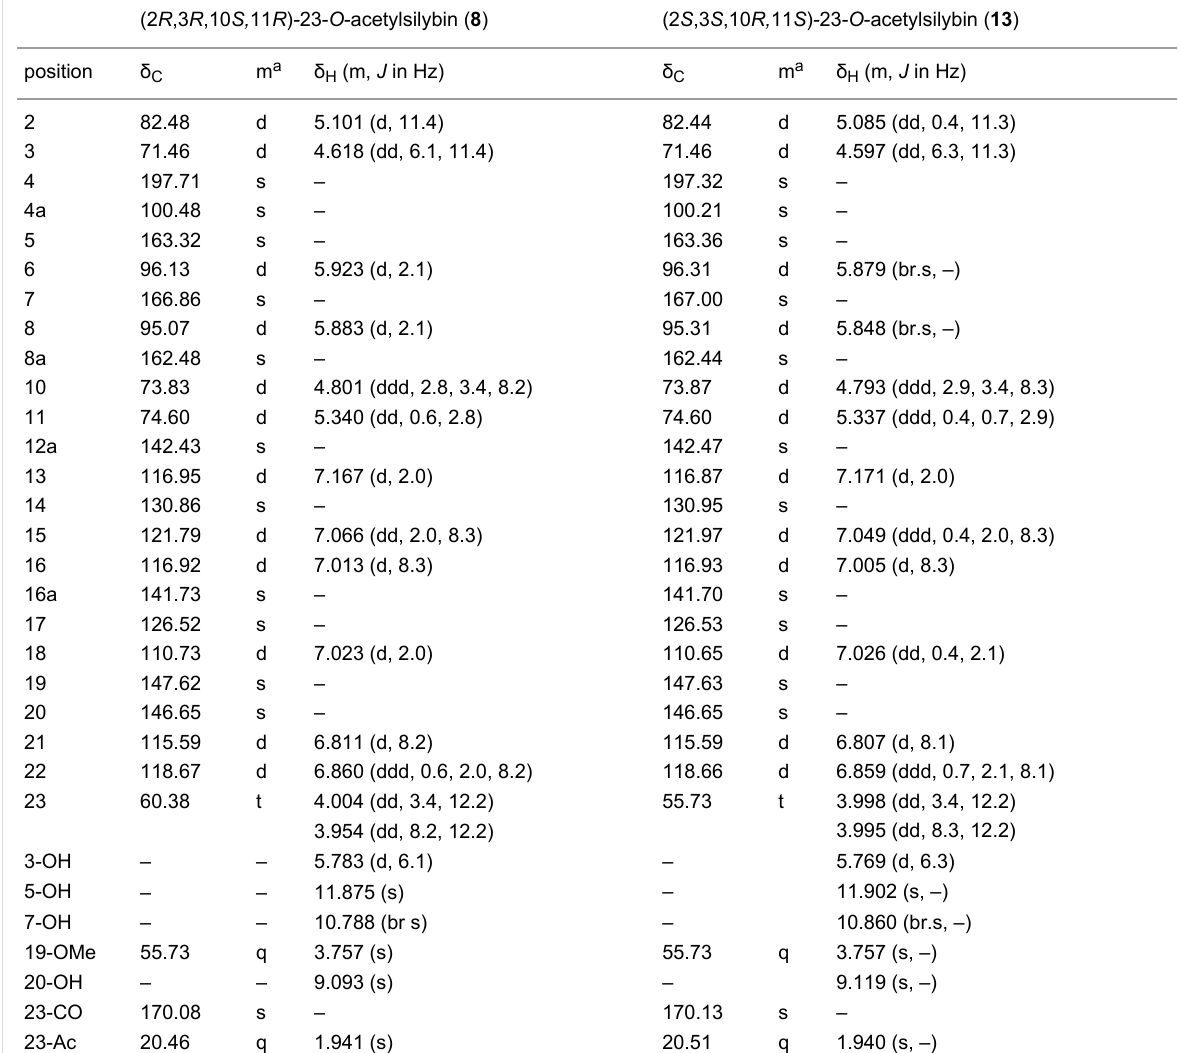
Table 7: NMR spectroscopic data (600 MHz, DMSO- d 6 , 30 °C) of compounds 8 and 13